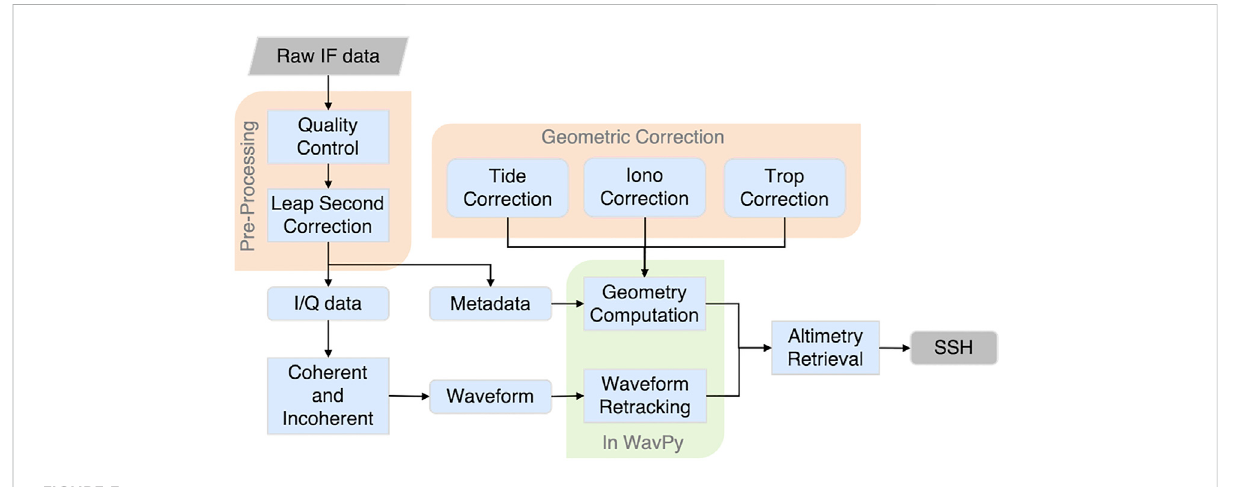
FIGURE 3 SSH retrieval procedure based on raw IF